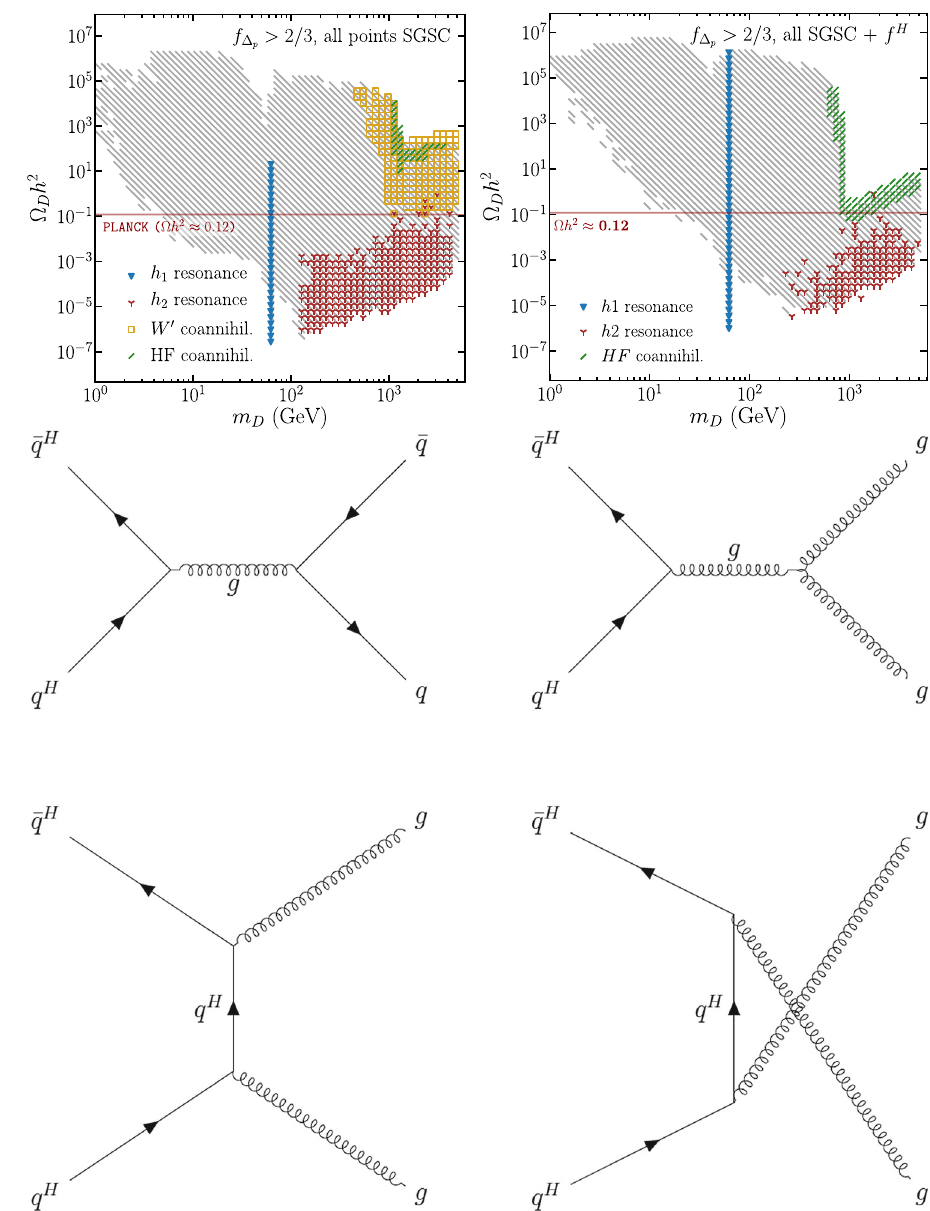
Fig. 2 The left panel describes triplet-like DM SGSC surviving regions projected on ( m D , (cid:13) 2 ) adopted from [32]. This D h figure neglects heavy fermions contributions. The inclusion of heavy fermions (with 5% mass splitting) is depicted on the right panel. For both figures, there are no resonances and coannihilations in the gray area